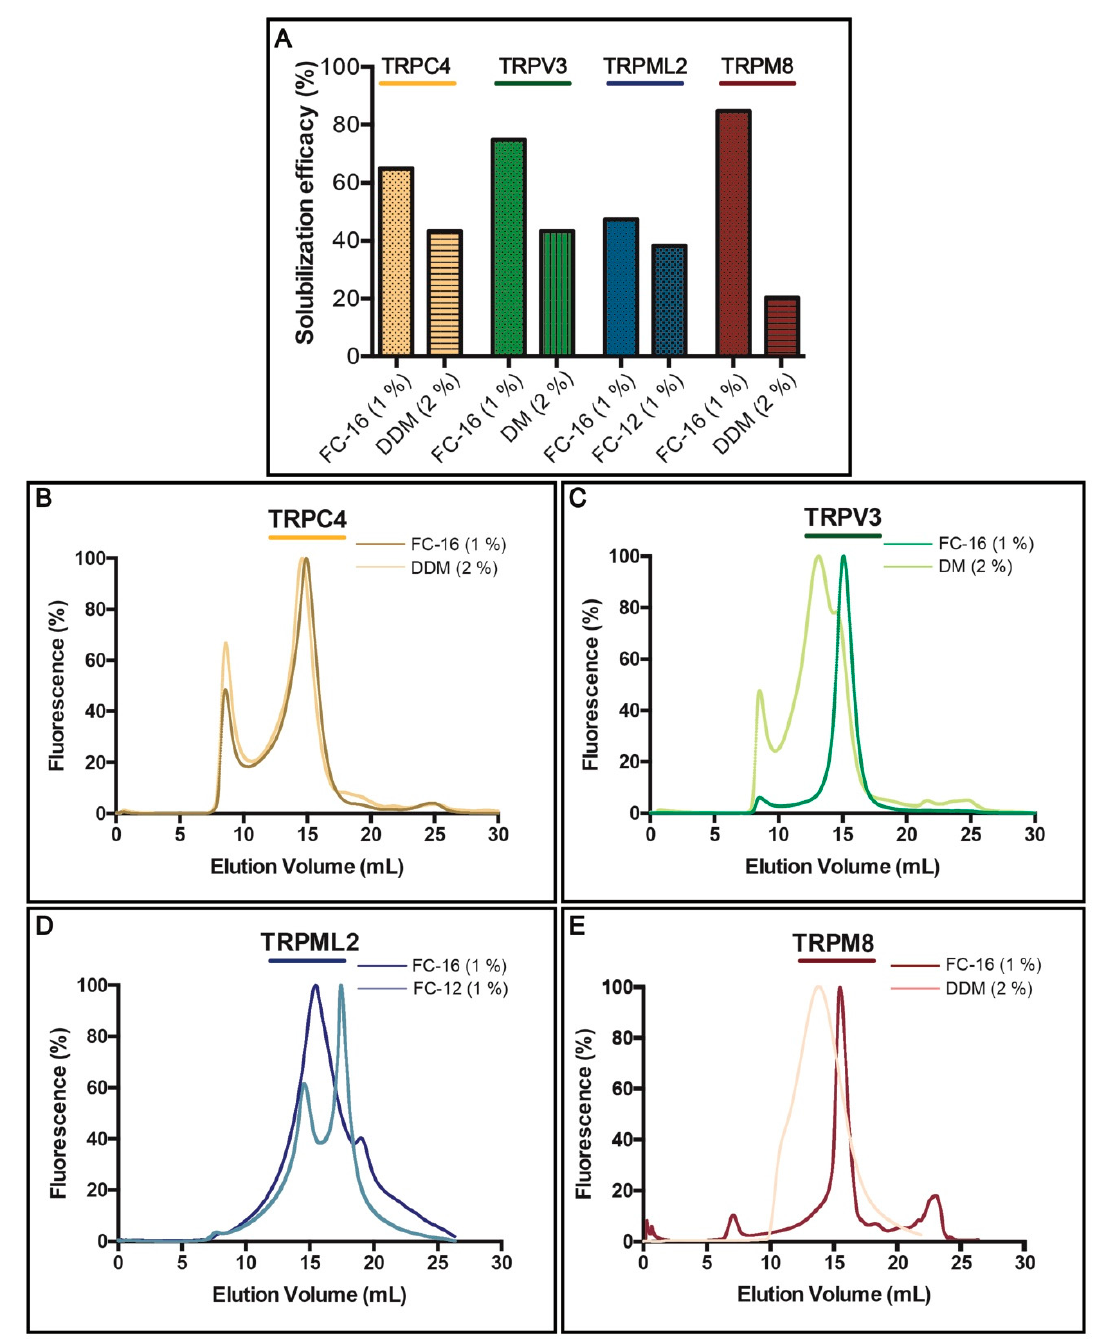
Figure 4. Solubilization and fluorescence-detection size-exclusion chromatography (F-SEC) of selected human TRP channels. ( A ) Solubilization efficacy in FC-12 (at a concentration of 1%), FC-16 (1%), DDM (2%) and DM (2%) of crude S. cerevisiae membranes for selected TRP channels. Solubilization was performed for 2 h at 4 ◦ C and GFP fluorescence of the solubilized material (supernatant following ultracentrifugation) was used to calculate the percentage of extraction. ( B – E ) F-SEC analysis of the detergent-solubilized samples. Concentrations of the corresponding detergents used during solubilization are indicated. Normalized F-SEC profiles were obtained for solubilized material separated on Superose 6 HR 10/30 column where GFP fluorescence was monitored. The void volume of the column (Superose 6 HR 10/30) is ~8 mL.